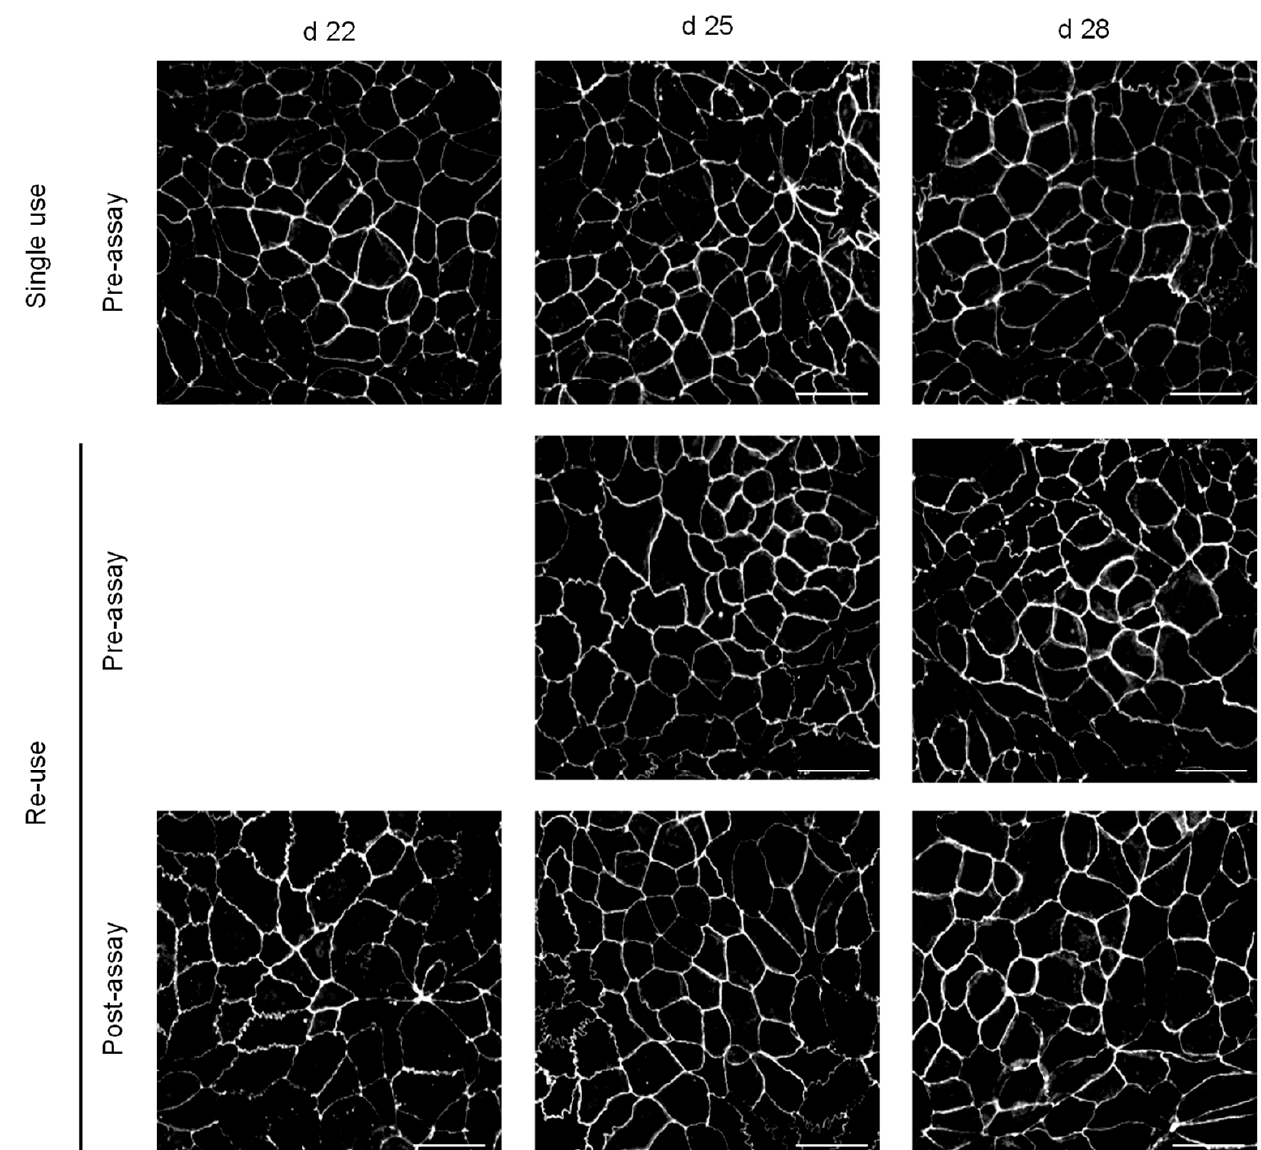
Figure 6. Immunofluorescence ZO-1 staining of Caco-2 monolayers. Representative images for cell monolayers at day 22, 25, and 28 are shown in the left, middle, and right panels, respectively. In the upper plots, the monolayer was not used in permeability assays, while in the additional plots the monolayers were previously used. The lower plots correspond to monolayers immediately after the LY permeability assay, and in the middle plots the images correspond to cell monolayers that were maintained in culture media for 2 days after the permeability assay. Scale bar 50 µm.